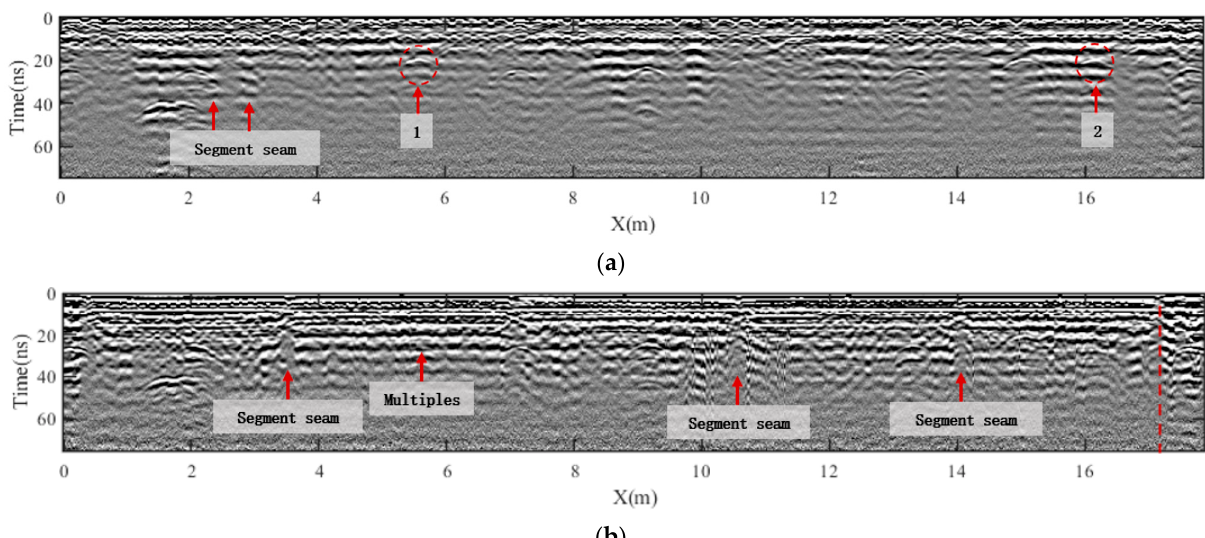
Figure 6. Test results of different transmitter-receiver configurations. ( a ) Electric field vector oscillating along the survey direction; ( b ) Electric field vector oscillating perpendicular to the survey direction.